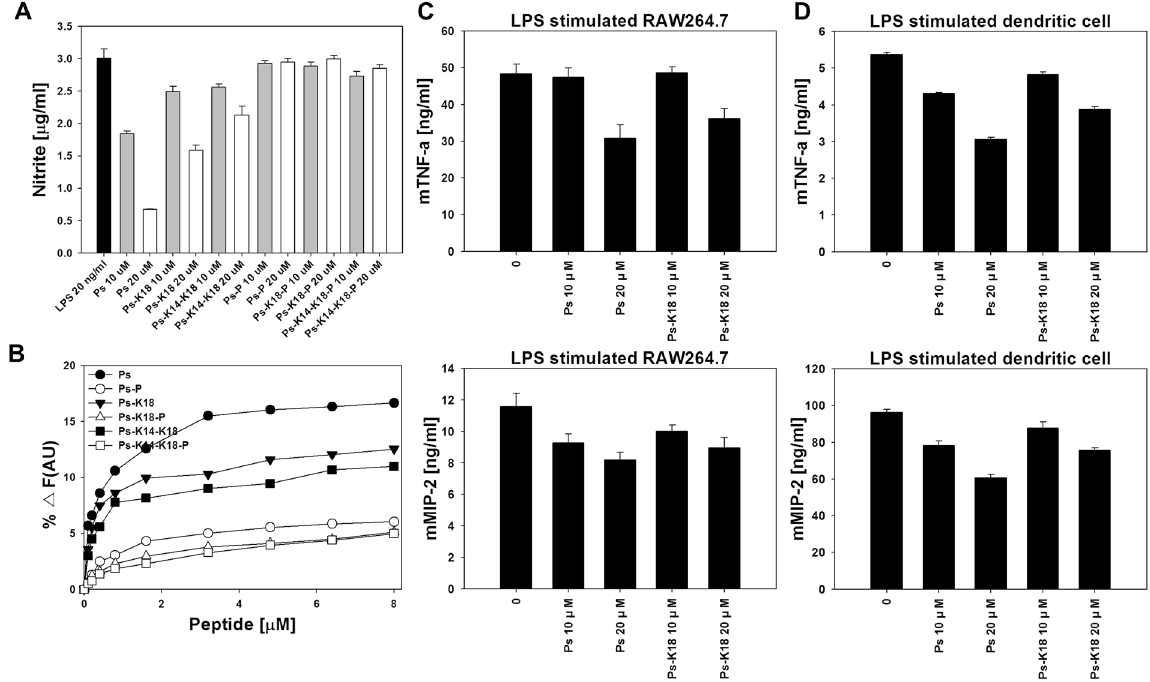
Figure 5. ( A ) Inhibition of nitrite production by peptides (10 μ M and 20 μ M) in LPS-stimulated RAW264.7 cells. ( B ) Disaggregation of LPS by the peptides. Enhancement of the intensity of FITC-labelled LPS as a function of the concentration of peptides. Effects of Ps and Ps-K18 on LPS-induced expression of inflammatory cytokines in ( C ) RAW264.7 cells and ( D ) dendritic cells as determined by enzyme-linked immunosorbent